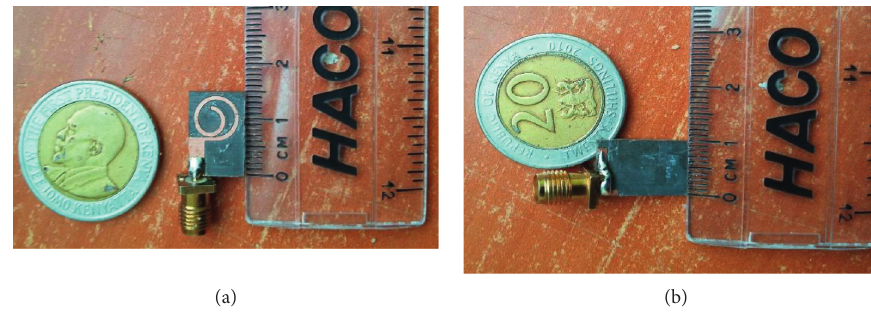
Figure 2: Prototype of the proposed ram horn-like folded antenna. (a) Top view. (b) Ground plane.